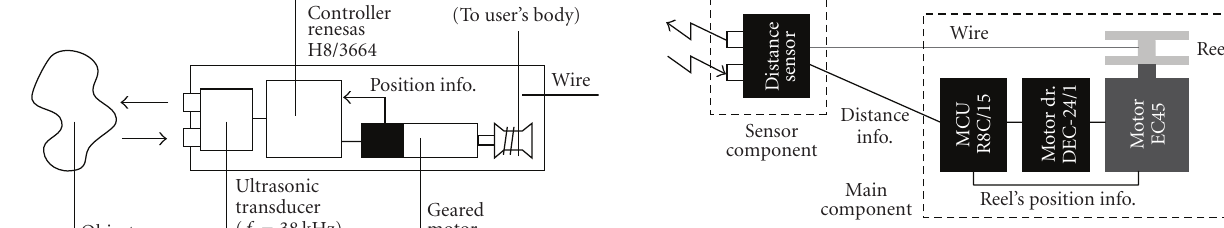
Figure 3: Mechanical architecture of first prototype of CyARM.